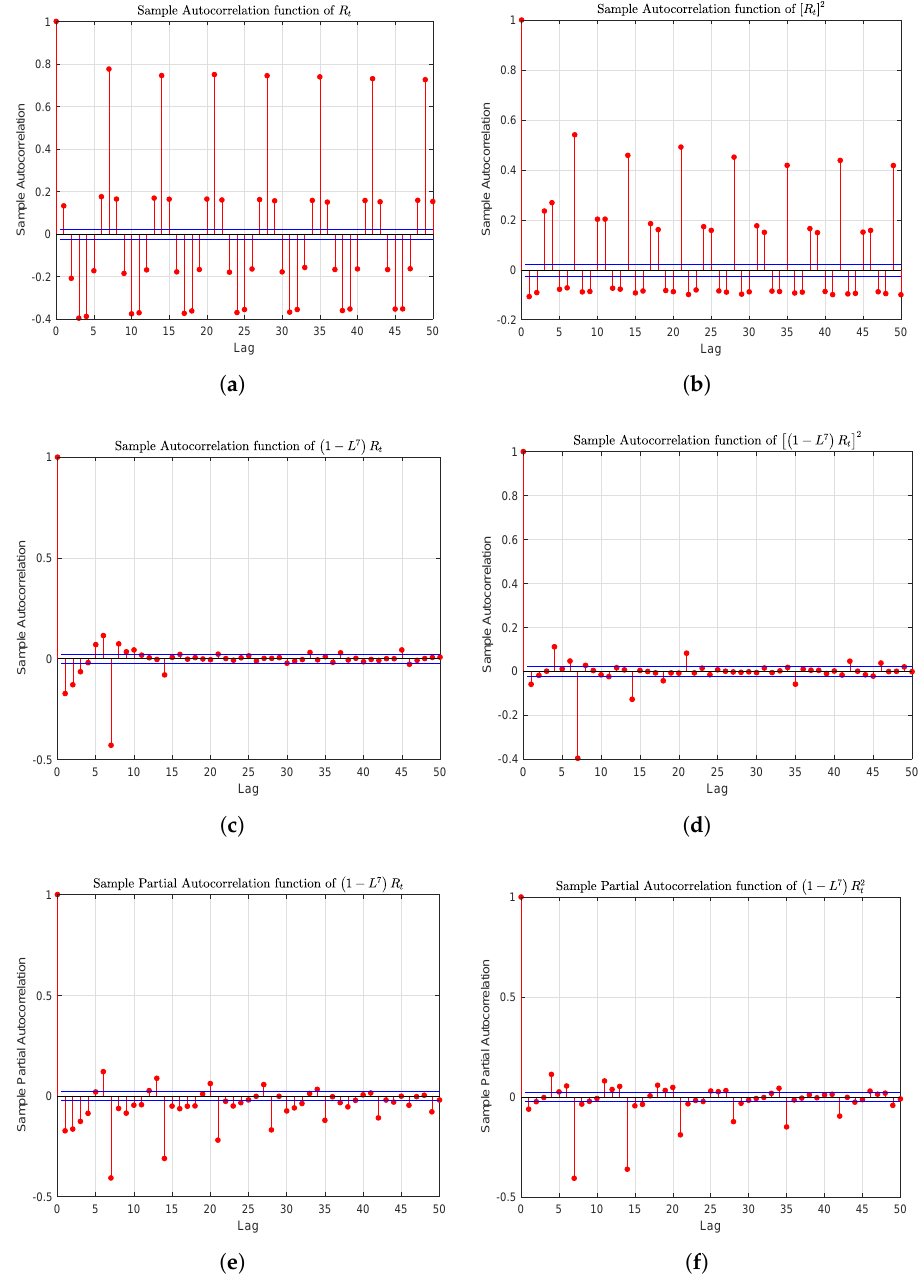
Figure 11. Sample autocorrelation of R t and R 2 autocorrelation functions of the filtered series sample partial autocorrelation